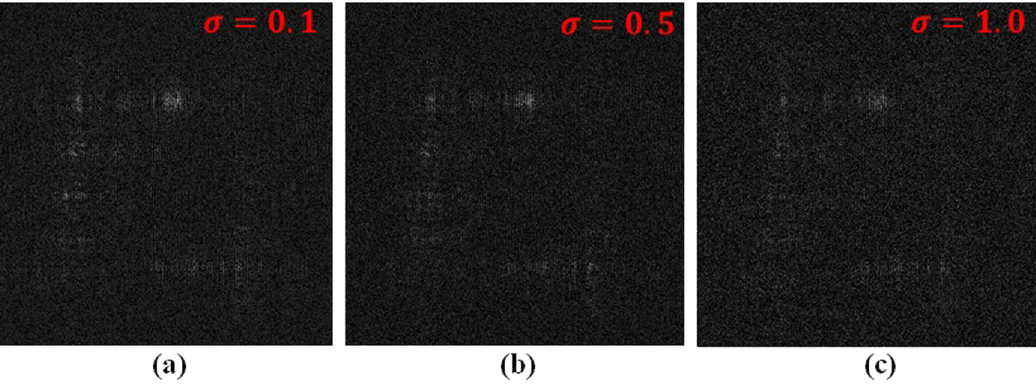
Figure 3: Simulated noisy digital Fresnel holograms with di ff erent standard deviations: ( a ) = σ 0.1 , ( b ) = σ 0.5 , and ( c ) = σ 1.0